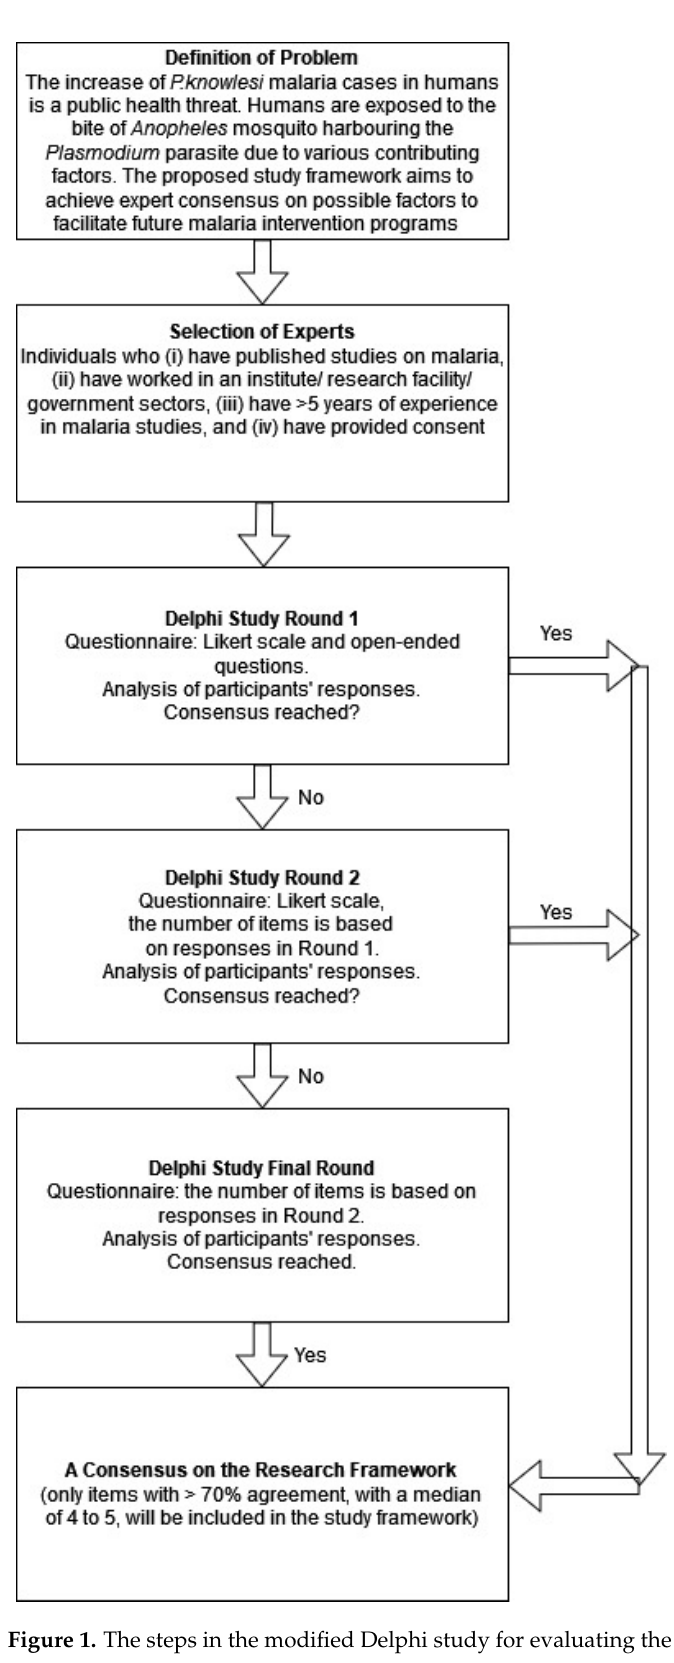
Figure 1. The steps in the modified Delphi study for evaluating the proposed study